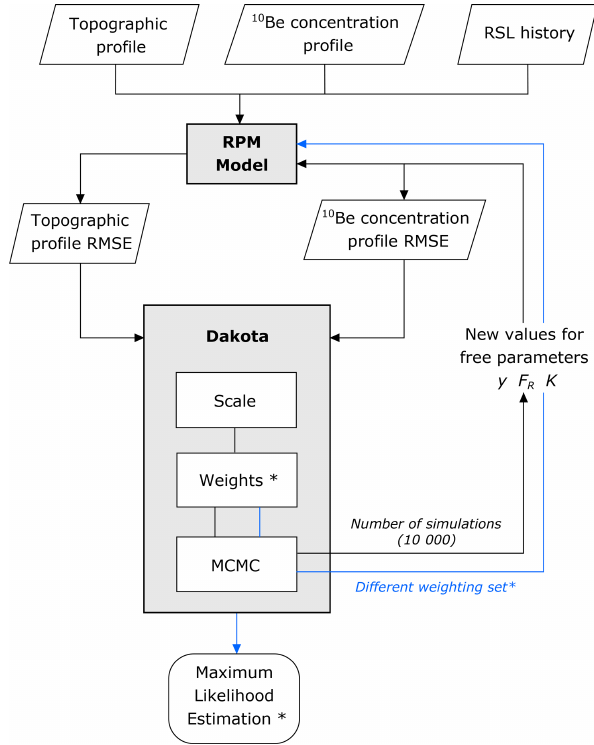
Figure 4. Structure for implementing a single MCMC calculation using Dakota. Data inputs into the coupled model include a topo- graphic profile, a 10 Be concentration profile, and an RSL history. The MCMC analysis is performed multiple times with different weightings (shown by the blue loop) for the objective functions (to- pographic profile RMSE and 10 Be concentration profile RMSE) and produces a corresponding maximum likelihood estimation (MLE ∗ ) result. For each MCMC calculation, the weights ∗ value is changed for each RMSE score. The different values for the weights ∗ are shown in Table 1 and correspond to w i (Eq. 2). The set of MLE results together produce the “Pareto front” of multi-objective opti- mised